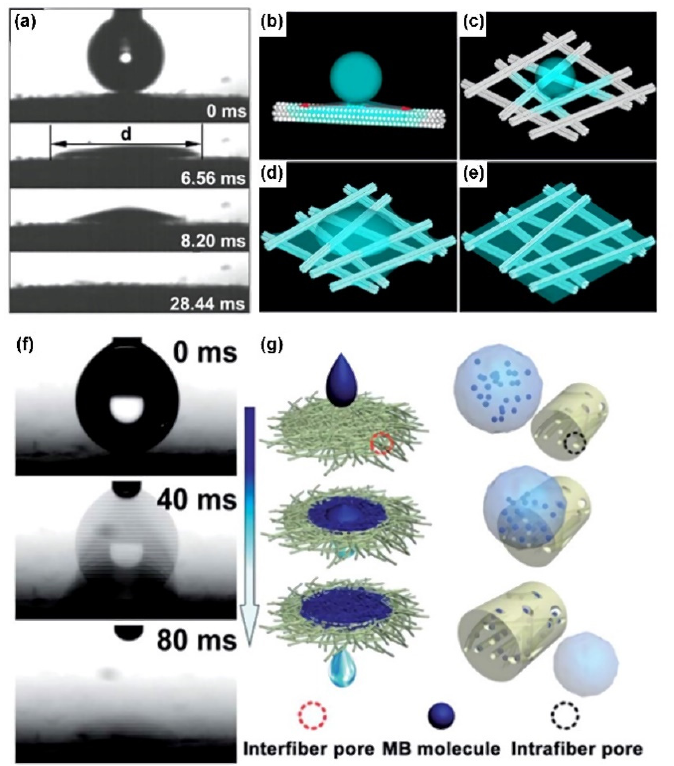
Figure 2. Ultra-fast spreading behaviors on the TiO 2 surface for water purification. ( a ) A water droplet spreads on a TiO 2 superhydrophilic mesh in 28.44 ms. ( b )The one-dimensional nanochan- nels of a single nanofiber, which generate a capillary effect to pull water along with the precursor water film. ( c ) The capillary effect of several nanofibers promotes the diffusion of water on the top surface of the fiber mesh. ( d ) The capillary effect caused by 3D micropores further promotes the diffusion of water droplets after inducing the invasion of water in the vertical direction. ( e ) The final state of the mesh shows contact angles (CAs) around 0°. Reprint from [52]. Copyright (2009), with permission from Elsevier. ( f ) A water droplet spreads on a flexible SiO 2 -TiO 2 composite po- rous nanomembrane in 80 ms. ( g ) The methylene blue solution spreads rapidly on the SiO 2 -TiO 2 composite porous nanofibrous membrane and permeates through the interspace between nano- fibers in the membrane. Meanwhile, methylene blue molecules are captured by intra-fiber pores, and then a water droplet is obtained. Reprint from [32]. Copyright (2013), with permission from The Royal Society of Chemistry. 3. Controllable Wettability In addition to superspreading properties, controllable superwettability, which de- notes the effective conversion between superhydrophilicity and superhydrophobicity, is widely studied and used in daily life because of its applications in smart devices such as printing, microfluidics, and water collection [56–60]. UV-induced superwettability was first reported by Fujishima et al. [11]. With UV- light illuminated on TiO 2 film, the water CA is 0°. After storing the film in the dark, a high CA of about 72° of the film is recovered. After that, much related research was further carried out. Kang et al. [33] reported on the under-oil switchable wettability of TiO 2 nano- tube arrays (TiO 2 -NTAs). Comparison between TiO 2 -NTAs and TiO 2 -films showed that they have the same superhydrophilicity in air but different wettability under-oil. With UV irradiation, TiO 2 -NTAs reveal CAs of about 0° under oil. After heating at 150 °C in air, the superhydrophobicity appears again. Zeng et al. [61] reported a new heterostructure with the TiO 2 -NTAs composited with Ni(OH) 2 , which shows a photo-induced color change by oxidative energy storage. The oxidative energy is generated by TiO 2 nanotubular arrays